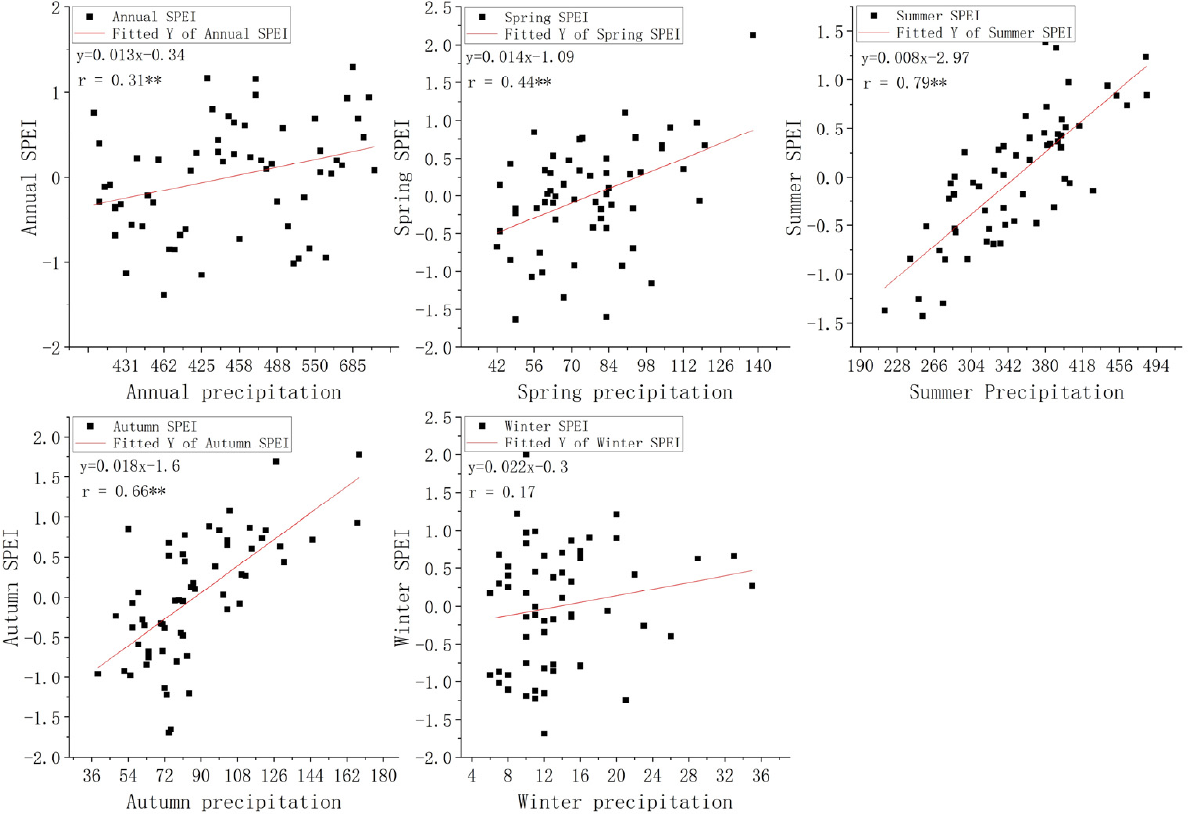
Figure 9. Relationship between precipitation and SPEI on a yearly and seasonal scale. The symbols ** indicate the trend that has passed the 99% significance tests. Table 5. Correlation coefficient between precipitation and SPEI on a monthly scale.